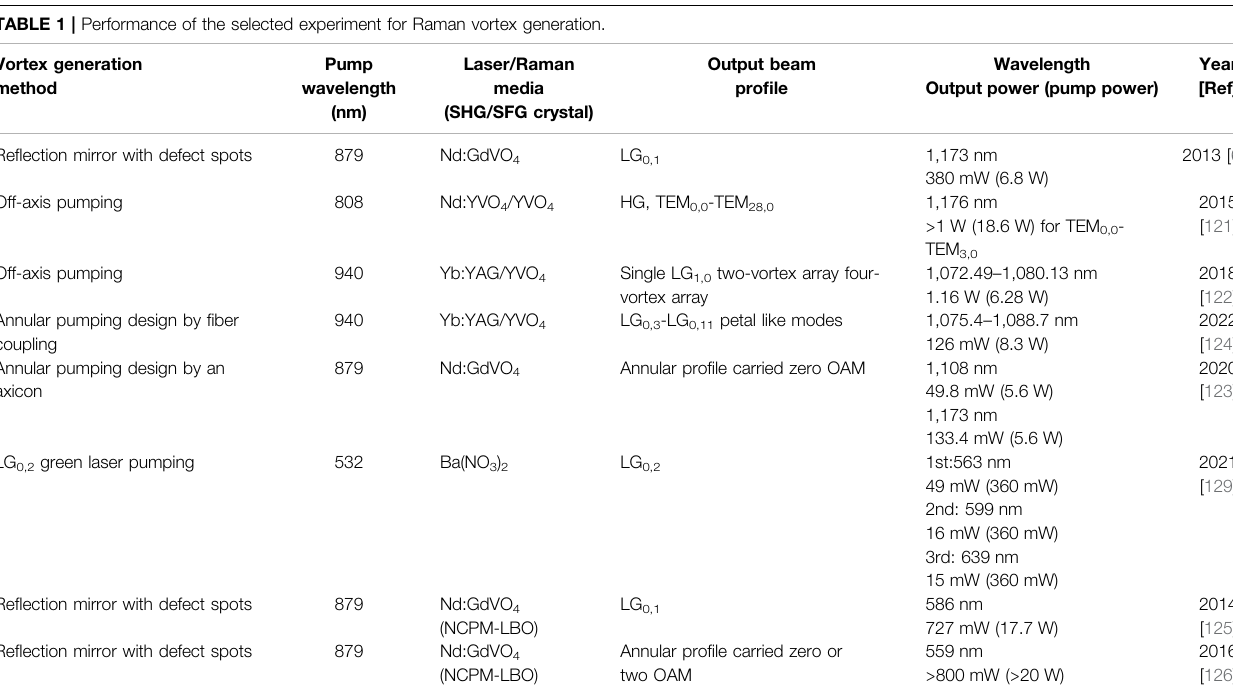
TABLE 1 | Performance of the selected experiment for Raman vortex